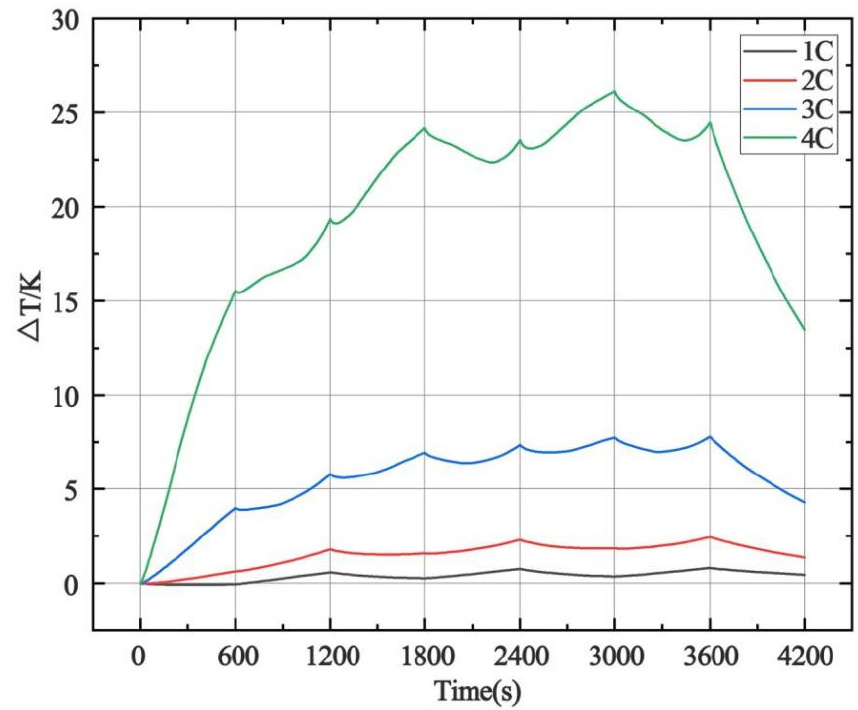
Figure 7. Average temperature changes of batteries at different charge–discharge rates.